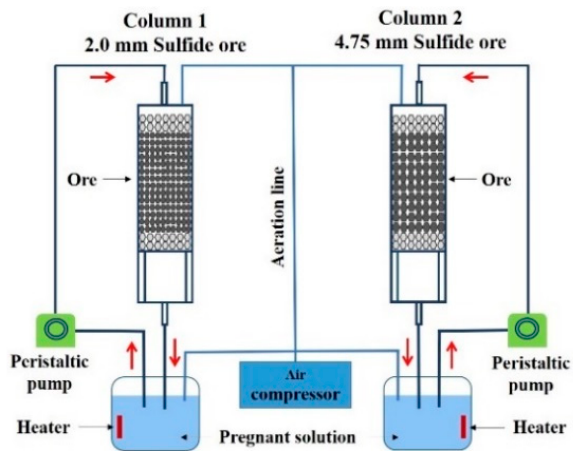
Figure 1. Columns bioleaching representative scheme.